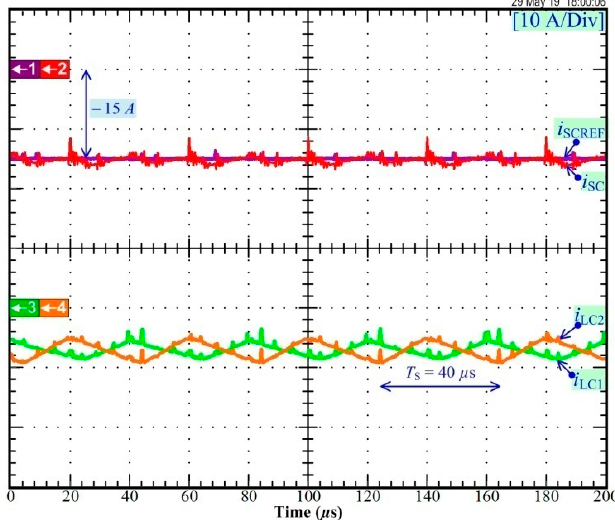
Figure 8. Steady-state waveforms of the SC converter at − 15 A.